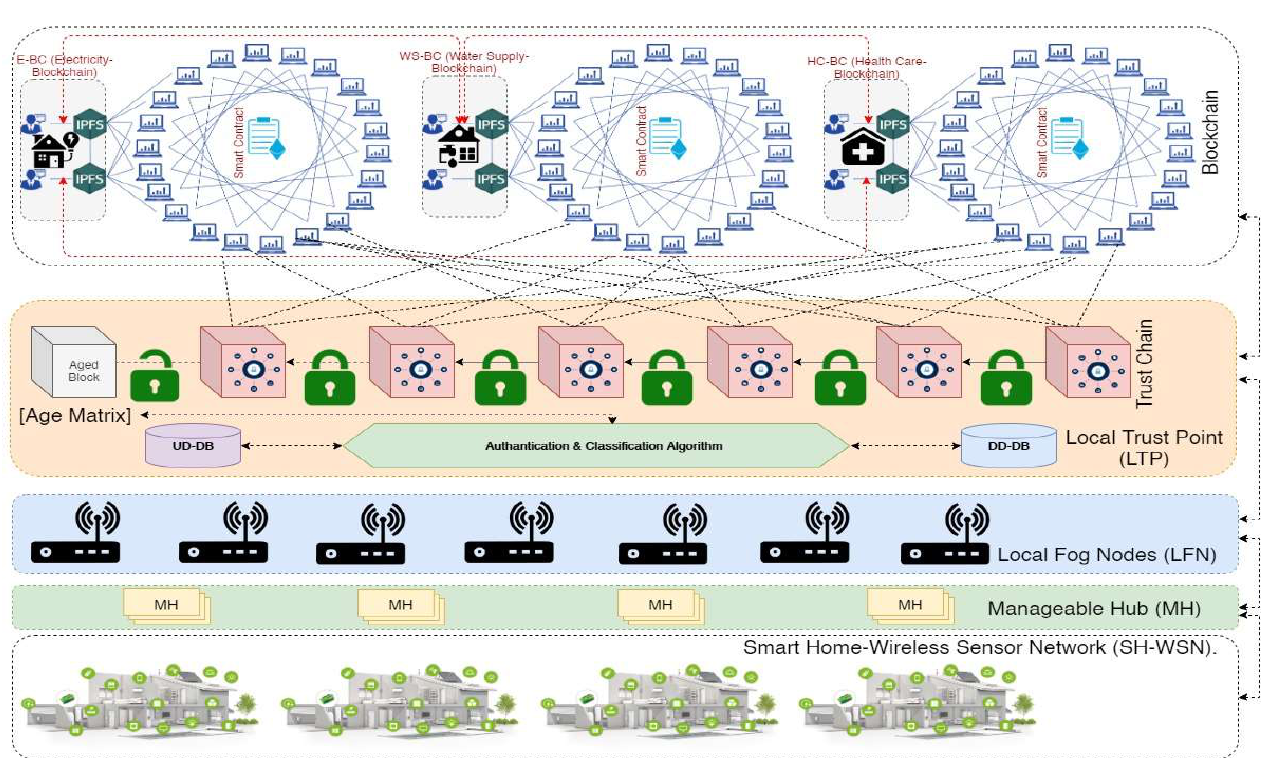
Figure 7. Components of proposed layered structure for smart city.